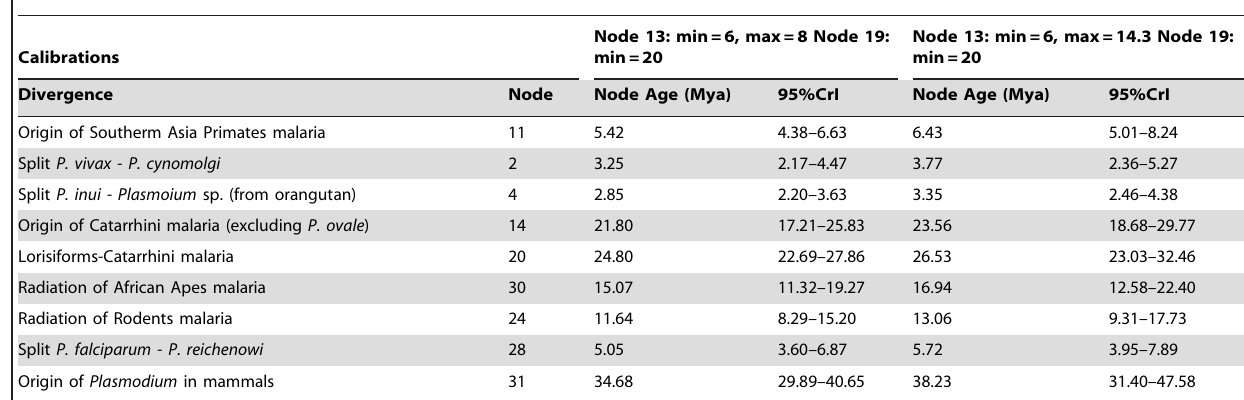
Table 5. Divergence times of major splits in the malarial phylogeny as estimated by BEAST.